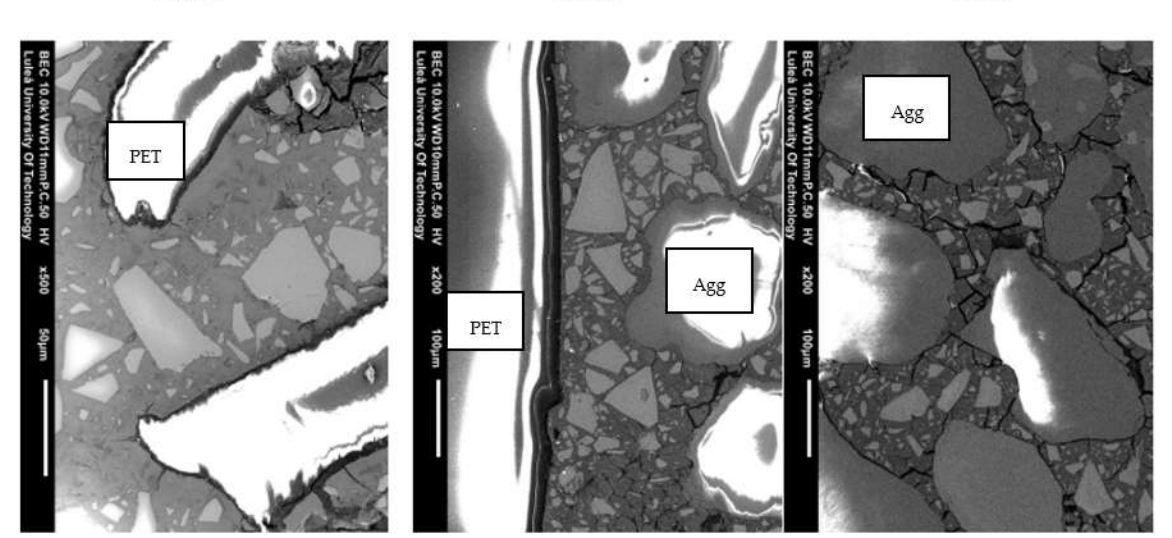
Figure 8. SEM images of mortars 20S20, 20S40 + P, and 20S80 + P.